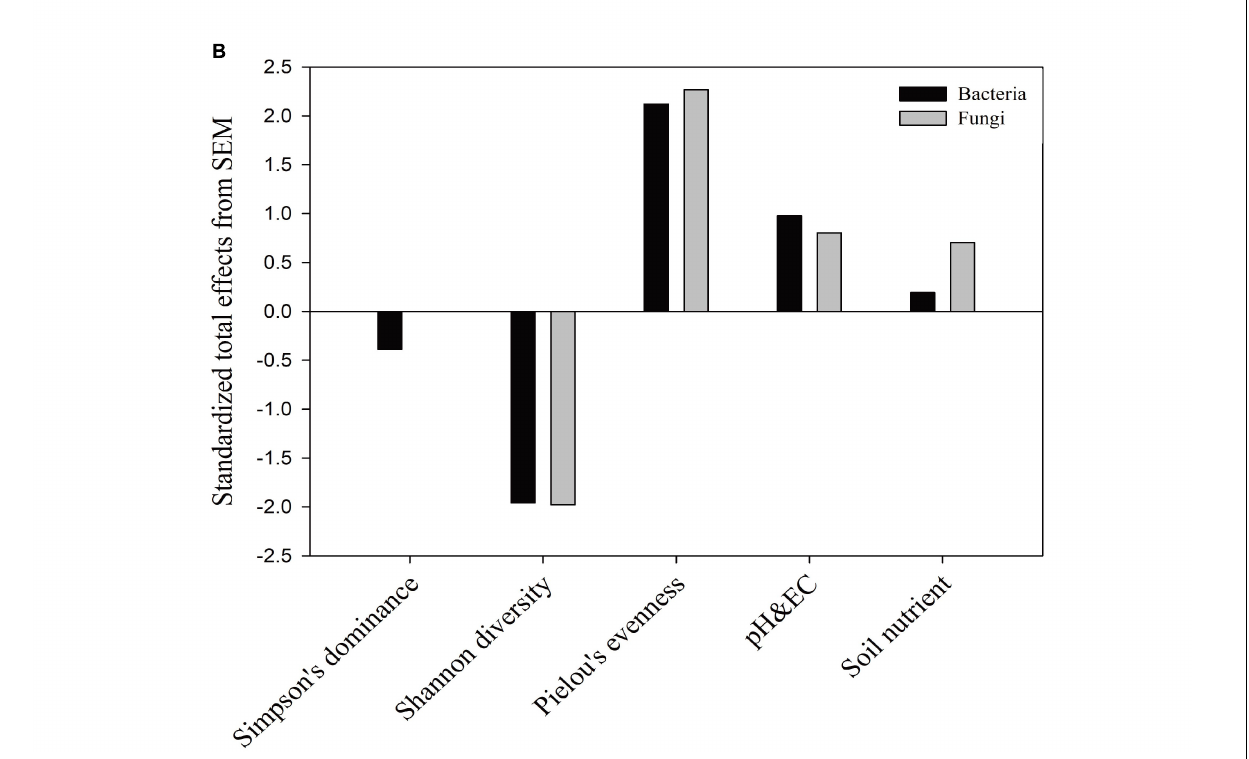
FIGURE 6 | Structural equation model (SEM) based on the effects of plant community composition (Shannon, Simpson’s, and Pielou’s indexes) and soil properties (soil nutrients, pH, and EC) on soil microbial communities (A) and the standardized total effects on plant community composition and soil properties based on the SEM (B) . Continuous arrows represent positive or negative relationships, and adjacent numbers in the same direction as the arrows indicate path coefficients. The R 2 values indicate the proportion of variance explained by each variable in the model. The significance levels are denoted as follow: *** P < 0.001.